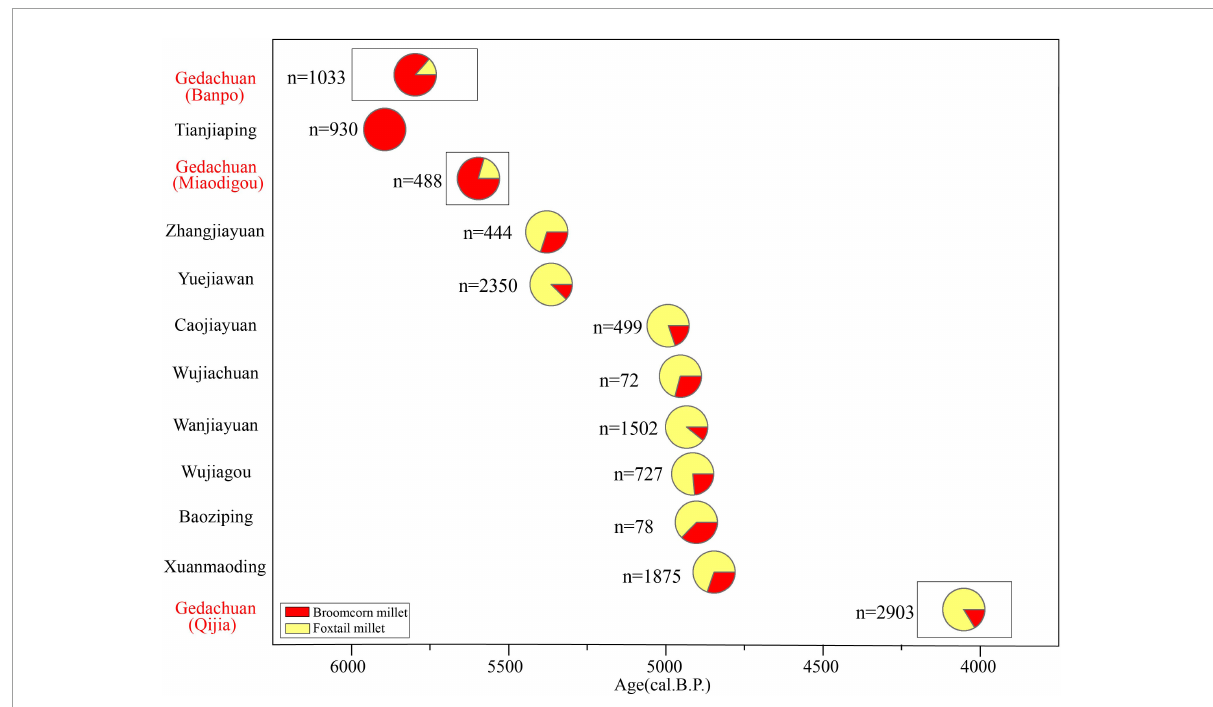
FIGURE5 Proportion of crop remains from different periods at the Gedachuan site (in red) and the Zhuanglang survey sites (in black). Black font represents the survey sites with identified crop remains data from Li (2018). n represents the number of identified crop remains.